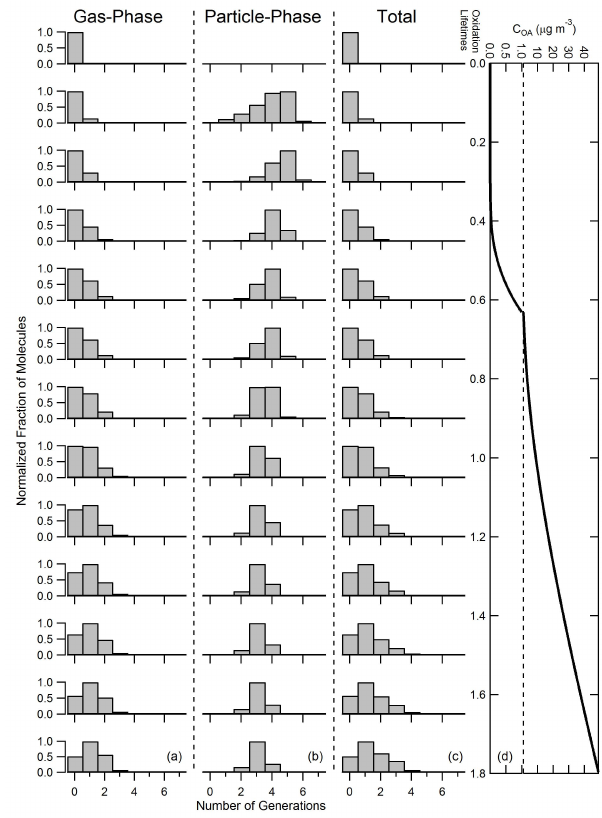
Fig. 1. The time-evolution of gas (a) , particle (b) and total (c) dis- tributions upon reaction of a generic hydrocarbon with OH, nor- malized to the maximum abundance at each point in the simulation. For reference, the evolution of the total OA mass is shown in (d) as a function of the number of oxidation lifetimes (note the split y-axis and change in scale). Note the continuous evolution of the compound